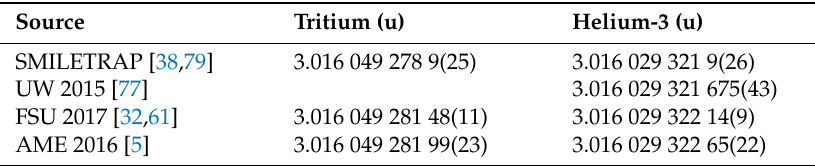
Table 5. Updated atomic masses of tritium and helium-3 (see text).